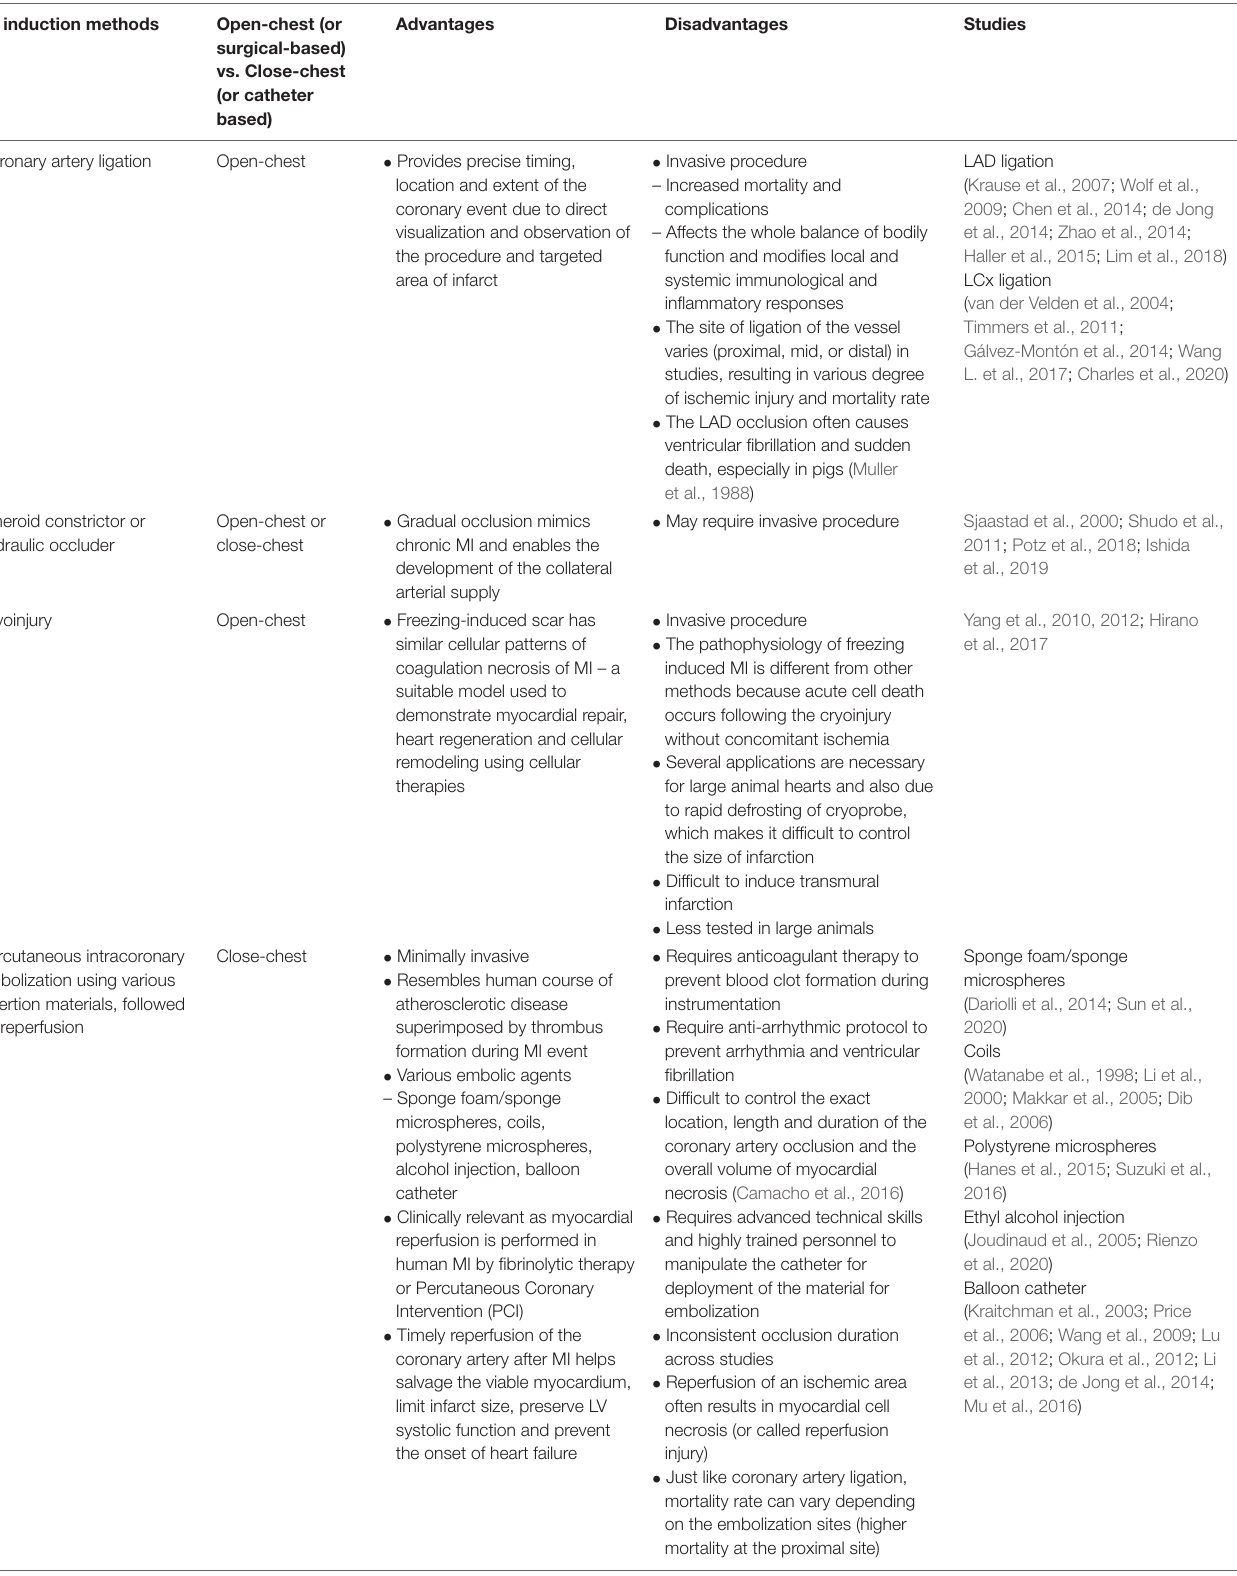
TABLE 2 | Comparison of surgical procedures used to induce MI in large animal